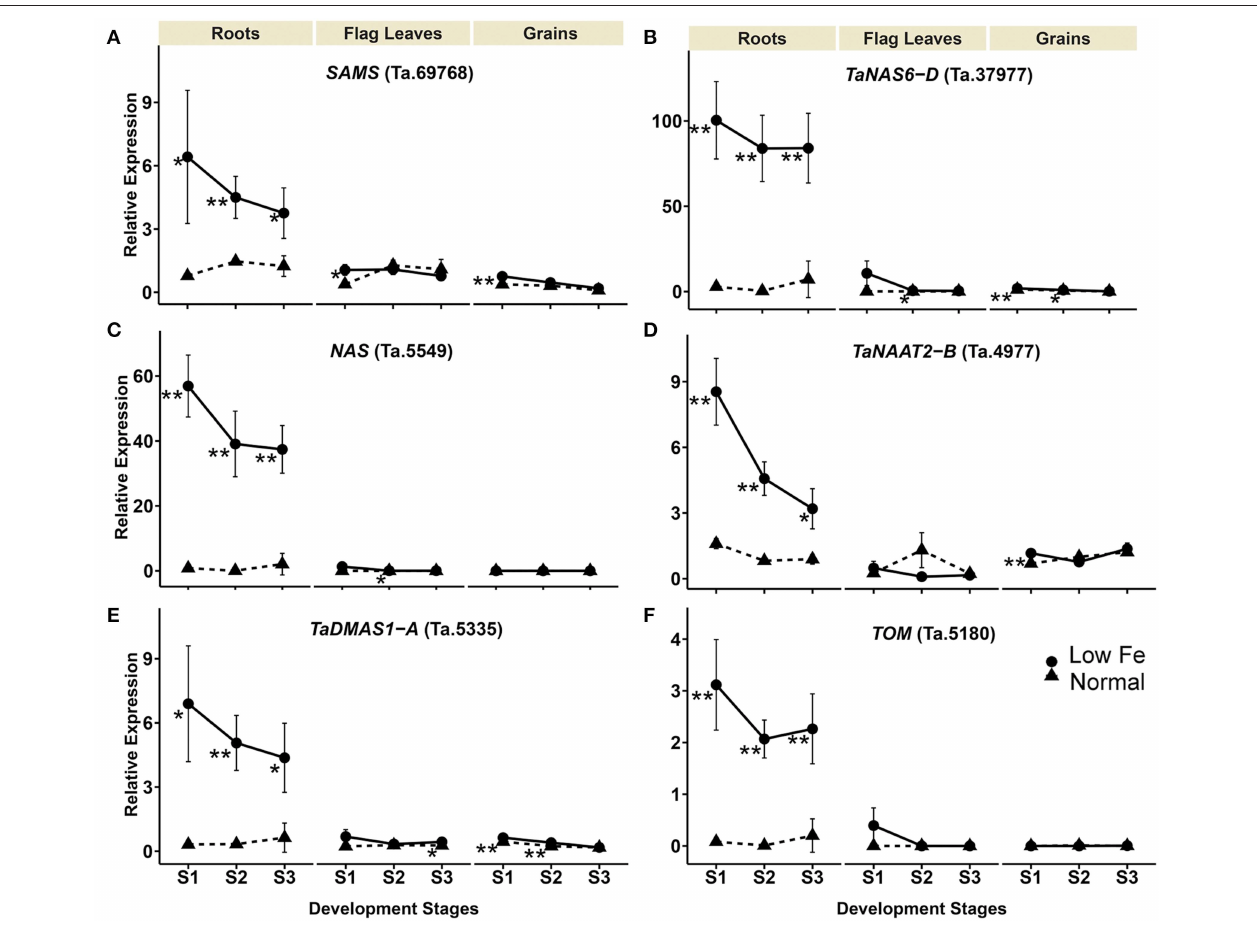
FIGURE 2 | Iron deficiency triggered differences in expression levels of wheat homologs of phytosiderophore synthesis related genes and the TRANSPORTER OF MUGINEIC ACID ( TOM ). The data collected at three different development stages, i.e., 8–10 DPA - days post anthesis (stage 1), 25–28 DPA (stage 2), and 33–35 DPA (stage 3) are presented. Values are the mean ± standard deviation of the three biological replicates (* p ≤ 0.05; ** p ≤ 0.01). Note the differences in scale at Y-axis for relative expression levels of tested genes. (A) SAMS (Ta.69768), (B) TaNAS6-D (Ta.37977), (C) NAS (Ta.5549), (D) TaNAAT2-B (Ta.4977), (E) TaDMAS1-A (Ta.5335), (F) TOM